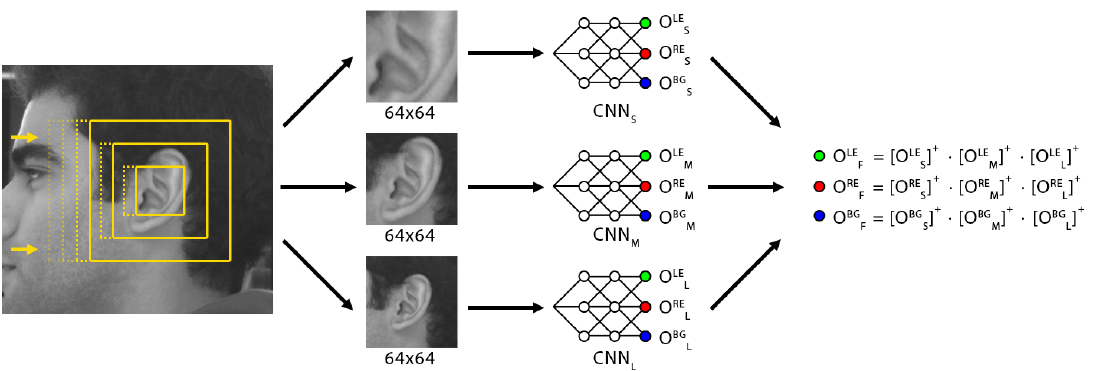
Figure 4. Data flow in the inference process of 3-CNN